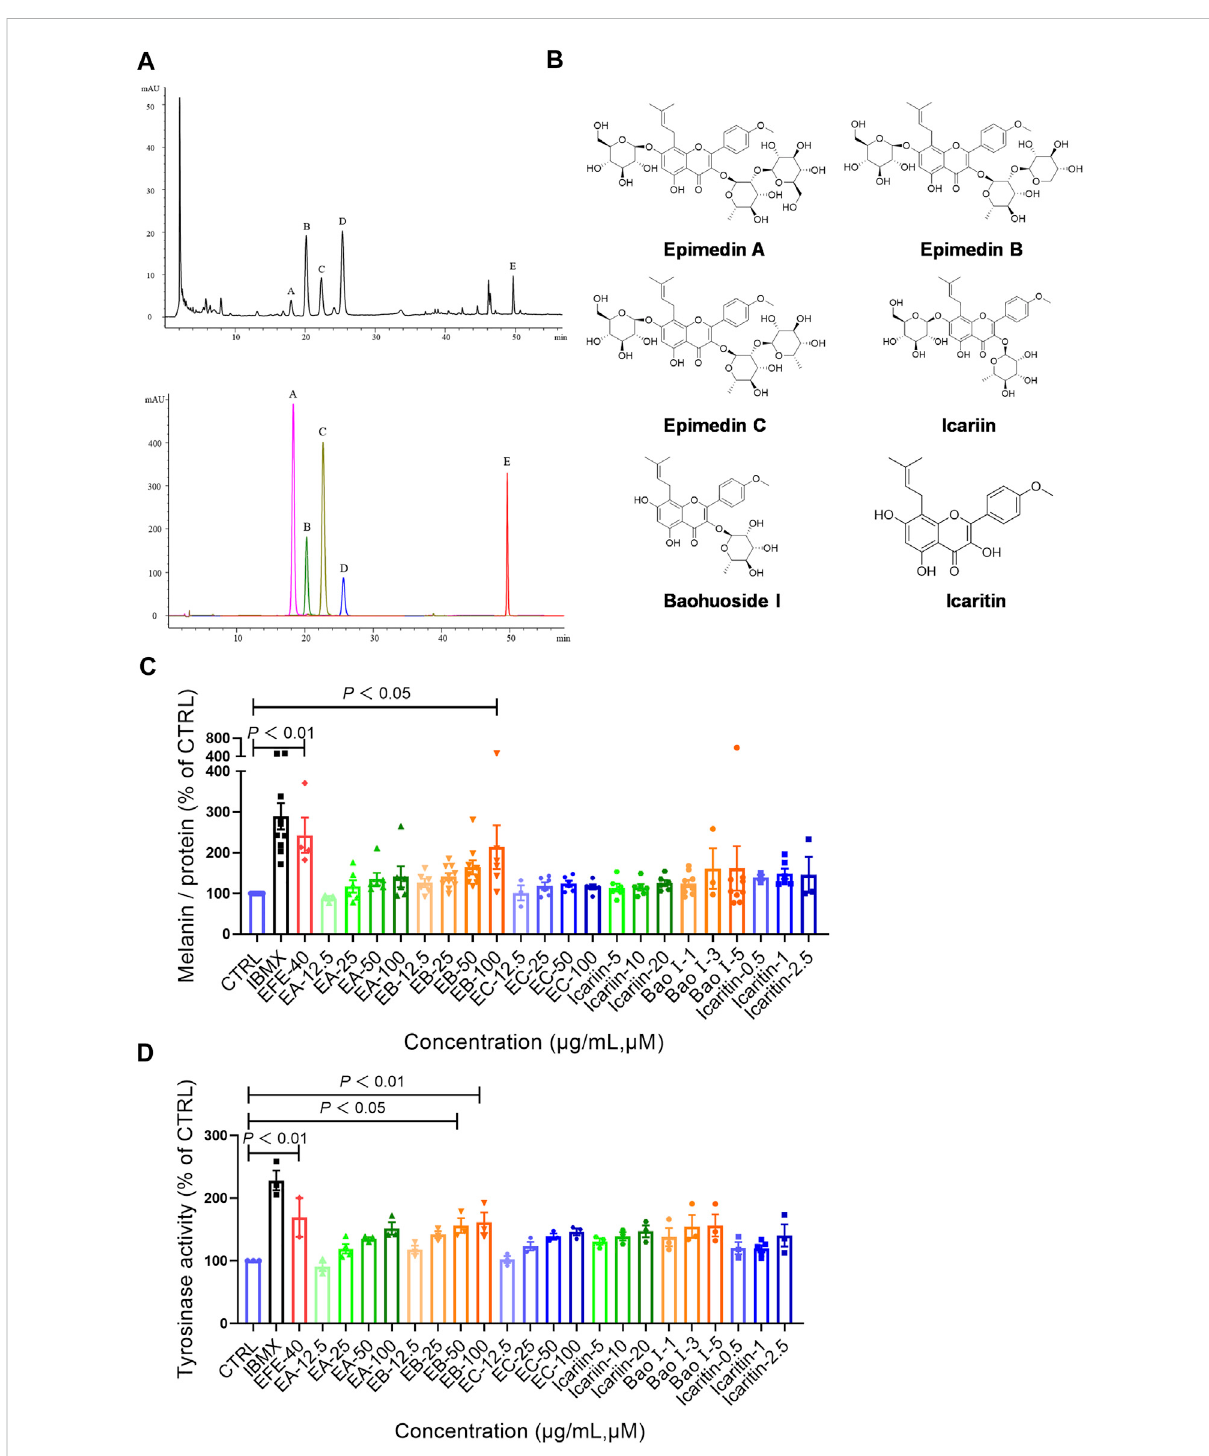
FIGURE 8 EFE ’ s fi ngerprint, main compounds ’ identi fi cation, and epimedin B as a high-content, low-toxicity, and effective compound in melanogenesis. (A) High-performance liquid chromatography pro fi les of EFE and fi ve main fl avonoid components; (B) fi ve main components and icaritin structures; (C) melanin contents by six components with different concentrations ( μ M), IBMX (100 μ M), and EFE (40 μ g/ml); (D) tyrosinase activity by six componentswithdifferentconcentrations( μ M),IBMX(100 μ M),andEFE(40 μ g/ml).Forgraphicalrepresentation,dataarepresentedasmean± SEM ( n ≥ 3 in each group), p < 0.05, p < 0.01, and p < 0.001 vs. CTRL are considered signi fi